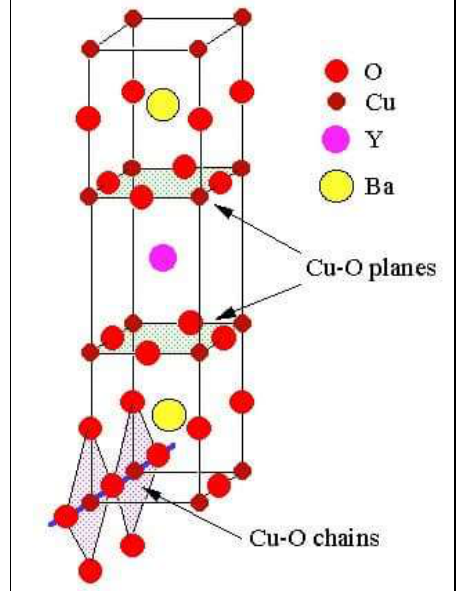
Figure 5: Part of the lattice structure of Y-Ba-Cu-O